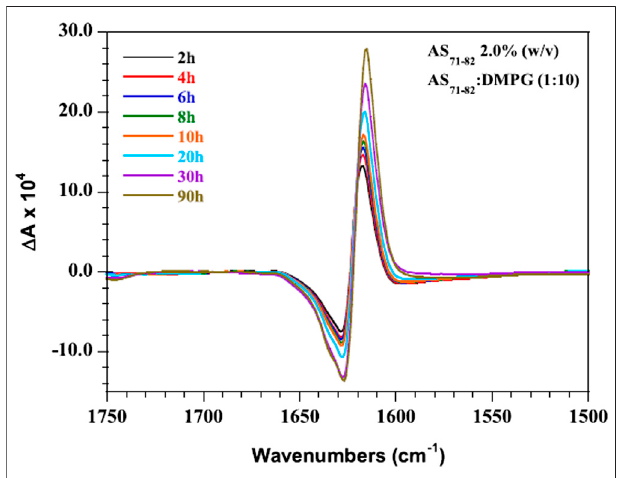
FIGURE 5 | VCD spectra of AS 71 − 82 in the presence of DMPG membranes (P:L 1:10, 2.0% AS 71 − 82 w/v) recorded as a function of time over a90 htimeperiod.The fi gureandcaptionhavebeenadaptedwithpermission fromMartialetal.,(2019),Copyright ©